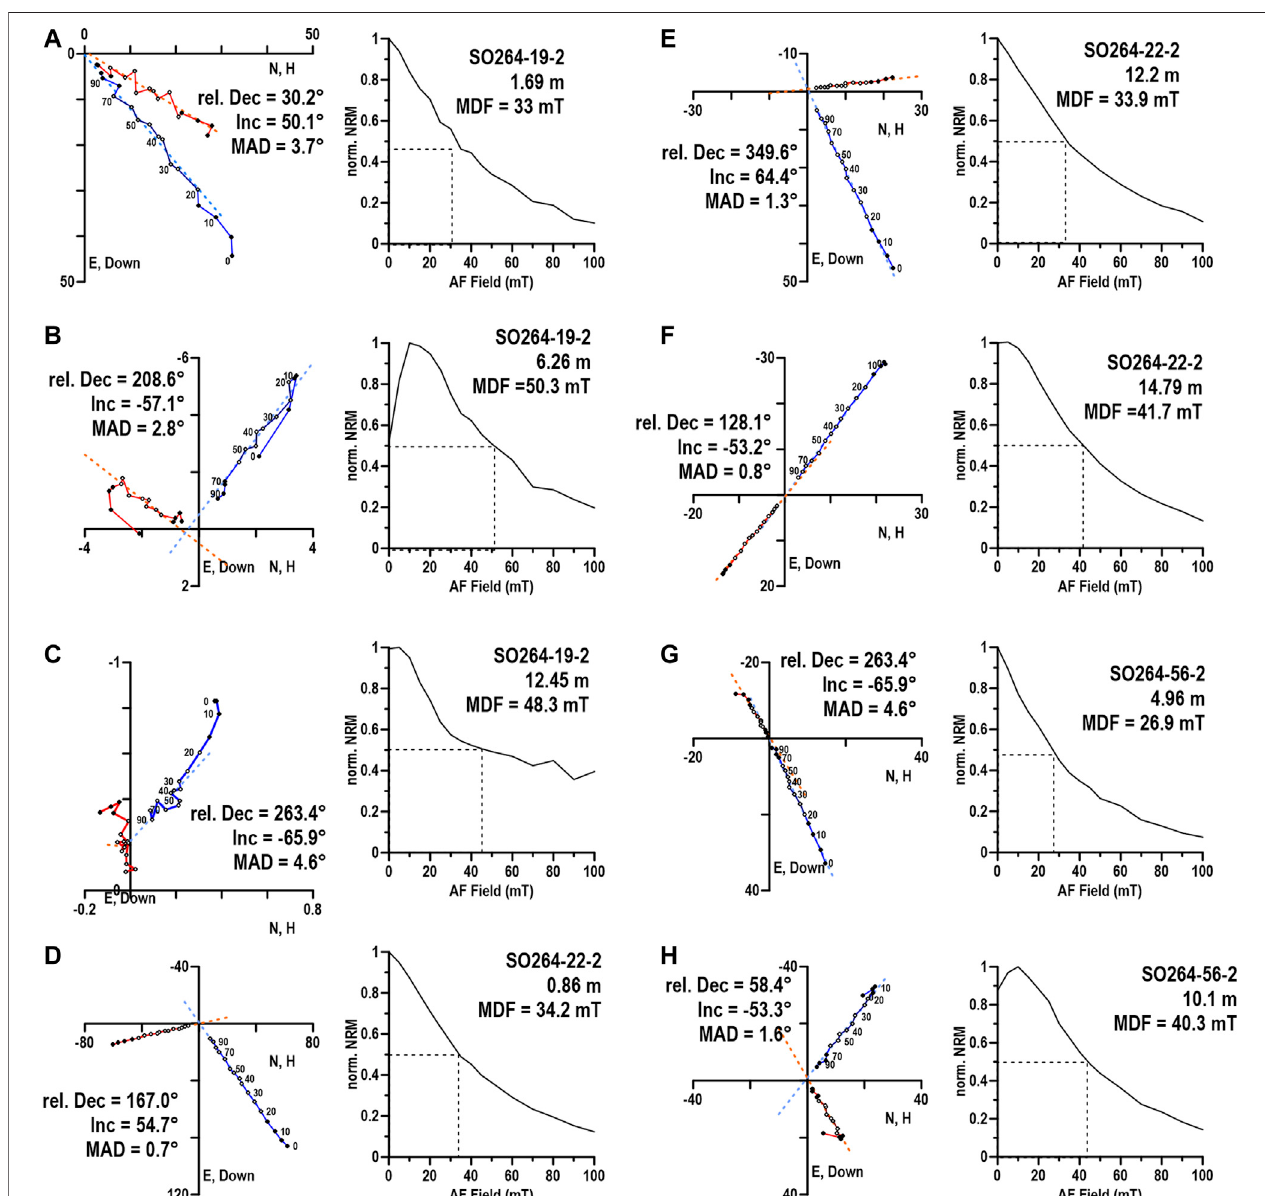
FIGURE 5 | Vector end-point (or Zijderveld) plots exemplarily showing NRM AF demagnetization characteristics of discrete samples of cores SO264-19-2, 22-2, and 56-2. Diagrams show projections of the NRM vector into the horizontal (H) vs. vertical (Z, Down) component plane (Inc. (cid:1) inclinations, in blue) and into the N vs. E component plane (Dec (cid:1) declinations without azimuth correction, in red) during AFdemagnetization. The AF demagnetizationplots show thechangein (mA/m; in black) during AF demagnetization; they were normalized to the highest and not the initial NRM values. This results in more realistic median destructive fi eld (MDF) values (dotted lines). Samples in (A,D,E,G) have normal polarity; samples in (B,C,F,H) have reverse polarity.